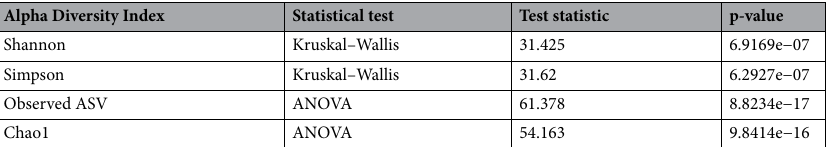
Table 1. Between group comparison statistics for alpha diversity measures of species richness (Observed ASVs and Chao1) and evenness (Shannon and Simpson) for endometrial lavage samples from Oklahoma, Louisiana, Australia and Dispersed.